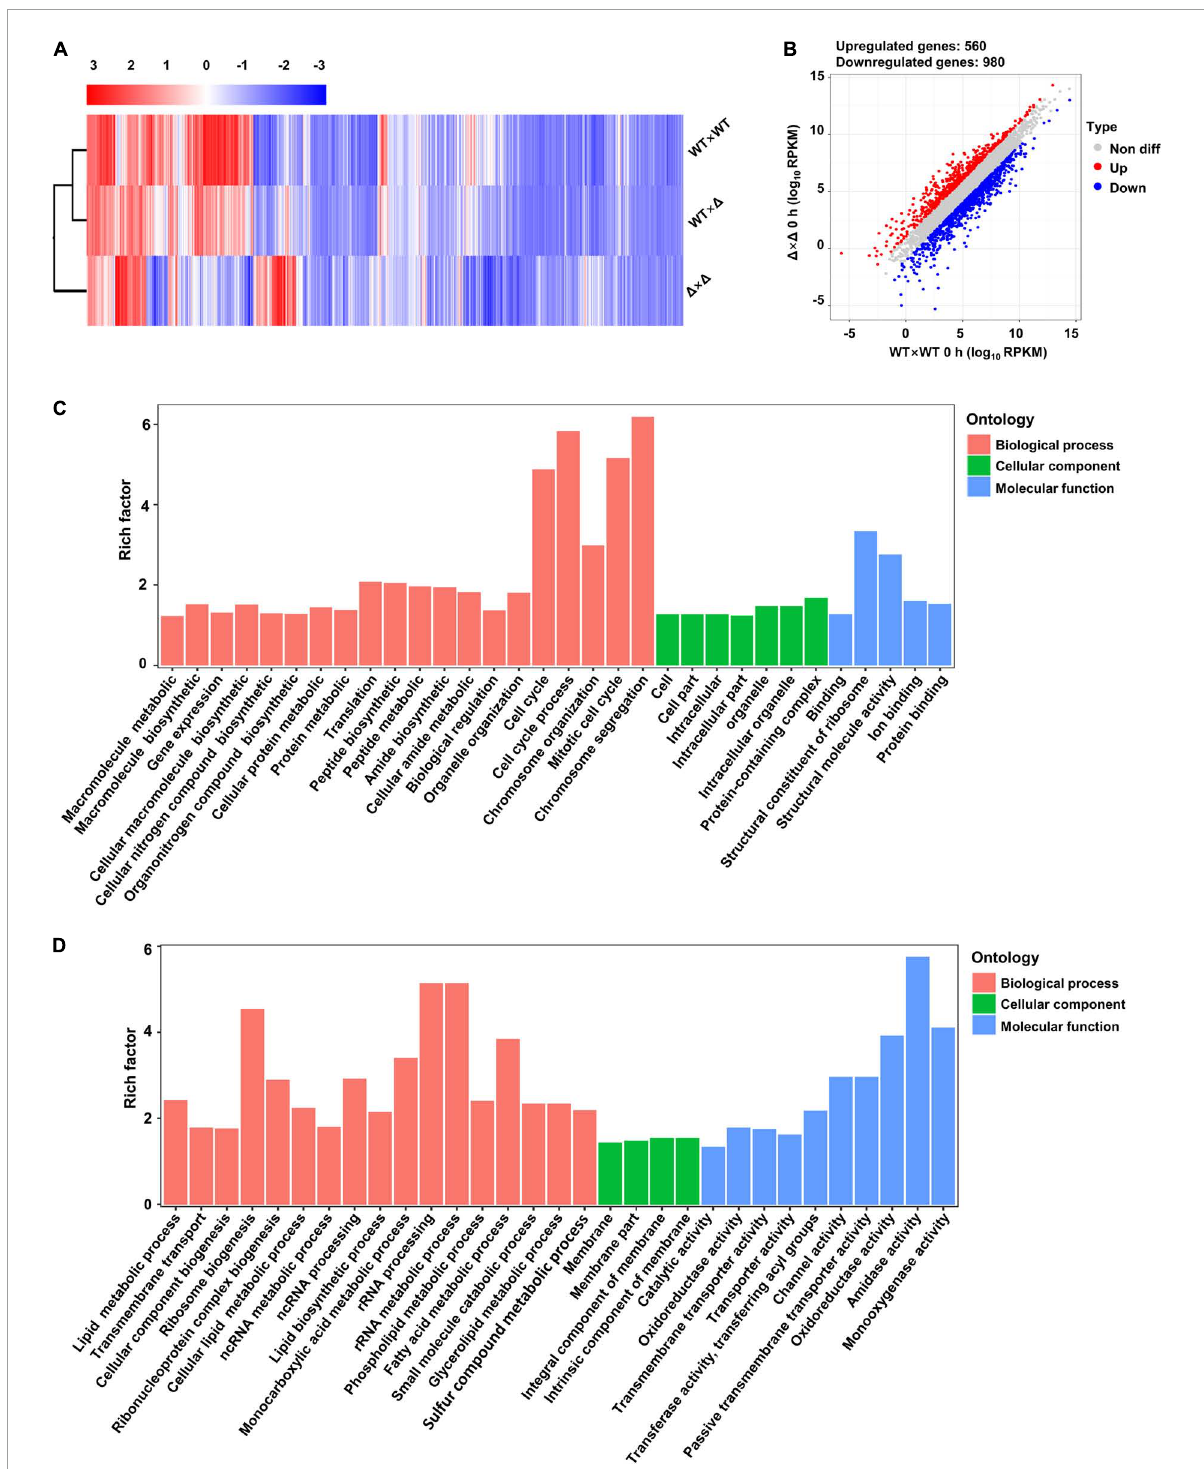
FIGURE5 Ssubc2 regulates the expression of a wide range of genes in the basidiospore stage. (A) Heat map of the RPKM values of differentially expressed genes (DEGs) of WT × WT, WT × (cid:49) , and (cid:49) × (cid:49) combinations at time 0. Red indicates high expression, and blue indicates low expression. (B) Scatter plot of DEGs in (cid:49) × (cid:49) compared to WT × WT at time 0. Red dots indicate upregulated genes, and blue dots indicate downregulated genes. (C) Go enrichment analysis of upregulated genes in (cid:49) × (cid:49) compared to WT × WT at time 0. (D) Go enrichment analysis of upregulated genes in (cid:49) × (cid:49) compared to WT × WT at time